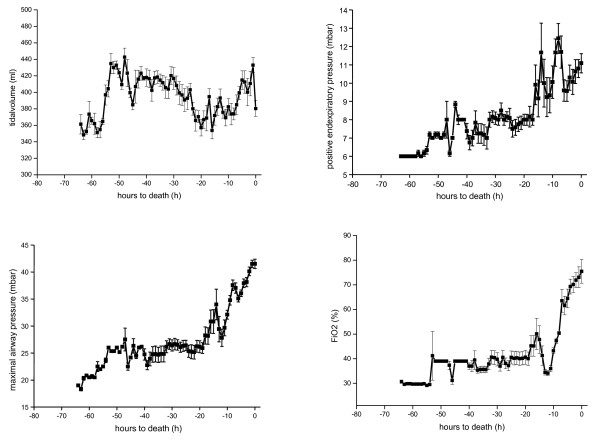
Ventilation variables tidal volume, PEEP, Pmax, and FiO2 in relation to hours to death.